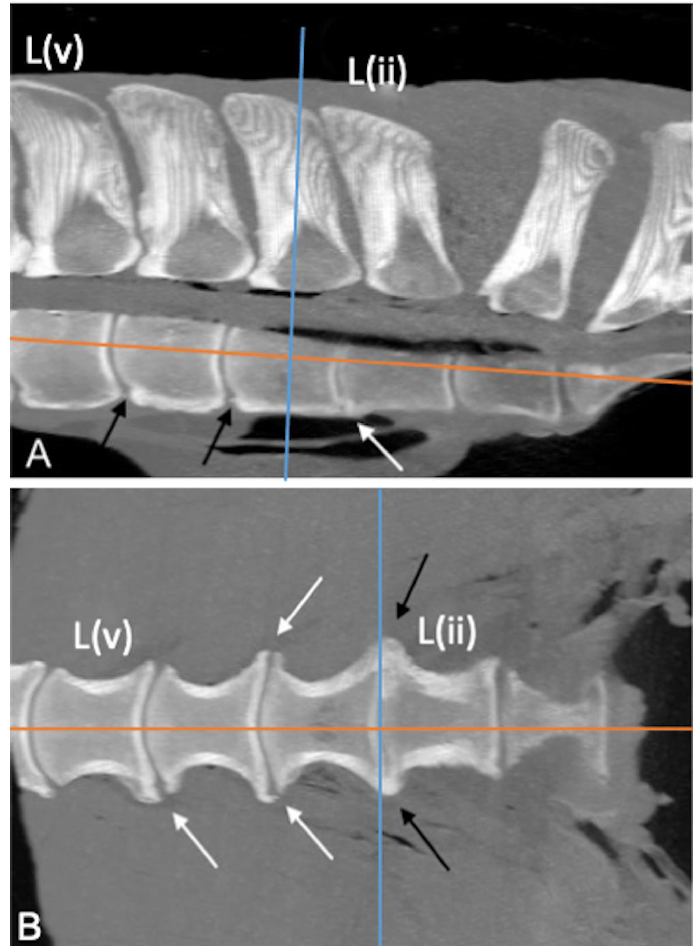
Figure 6. Sagittal ( A ) and dorsal ( B ) multiplanar reconstruction CT images of the lumbar specimen 16; cranial is toward the left. ( A ) Presence of small amounts of new bone formation involving the ventrocranial aspect of the L(iv) and L(iii) vertebral bodies (black arrows) and severe new bone formation causing vertebral bridging between the ventrocaudal aspect of L(iii) and the ventrocranial aspect of L(ii) vertebral bodies (white arrow); note the uncommon divergence of the spinous processes between L(ii) and L(i). ( B ) New bone formation of small/moderate size located at the lateral aspect of the vertebral bodies from L(v) to L(iii) (white arrows). Severe new bone formation onto the lateral aspect of the L(iii)-L(ii) vertebral bodies bilaterally, resulting in fusion of the respective vertebrae (black arrows). L: left; R: right; L(v): fifth to most caudal lumbar vertebra; L(iv): fourth to most caudal lumbar vertebra; L(iii): third to most caudal lumbar vertebra; L(ii): second to most caudal lumbar vertebra; L(i): most caudal lumbar vertebra. The details of the mean HU of the vertebral body endplates and localization of spon- dylosis are summarized in Table 5.